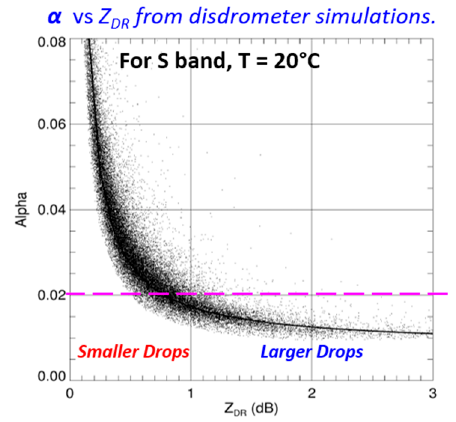
Figure 9. The scatterplot of α versus Z DR simulated from the Oklahoma disdrometer data at λ = 11.0 cm and T = 20 °C. Black curve represents the α ( Z DR ) dependence specified by Equation (8).